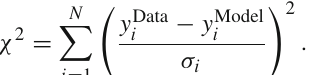
Fig. 1 Comparison of χ 2 / d . o . f based on the experimental data of a R AA and b v 2 . The model predictions are calculated by using various combinations of parameter α and β (Eq. 10), which are represented as